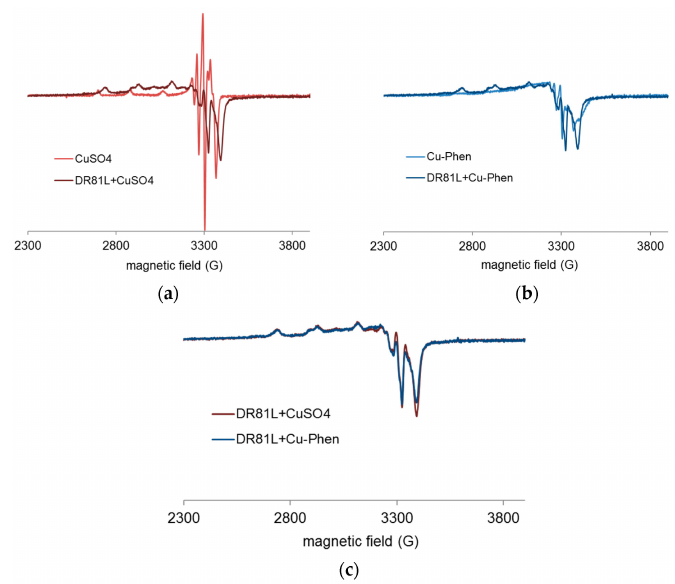
Figure 18. Experimental X-band EPR spectra recorded at 100 K in frozen aqueous solutions of ( a ) CuSO 4 and CuSO 4 + DR81 ( b ) Cu-Phen and Cu-Phen + DR81 ( c ) CuSO 4 + DR81 and Cu-Phen + DR81, at pH 12.3, with Cu:Phen molar ratio = 1:2, DR81:Cu molar ratio = 1:1.5 and [Cu] = 1.5 mM.